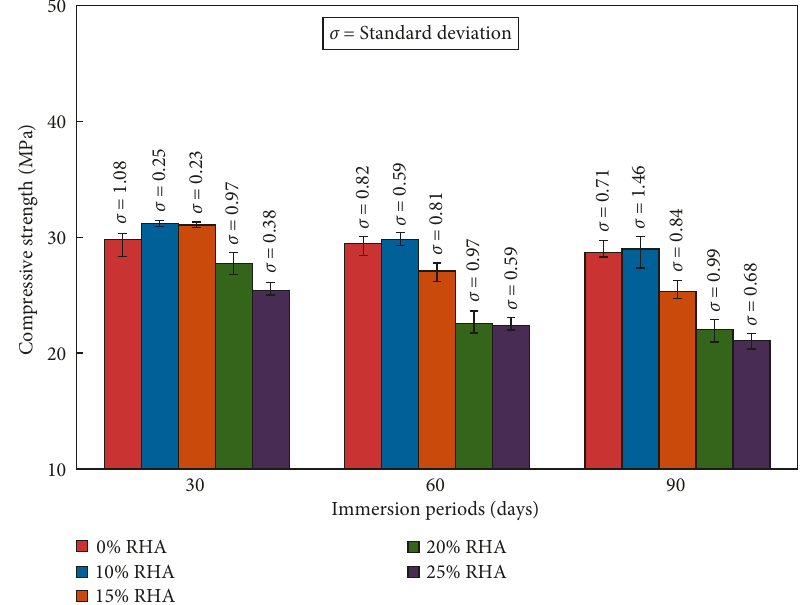
Figure 11: Compressive strength of RBAC immersed in H